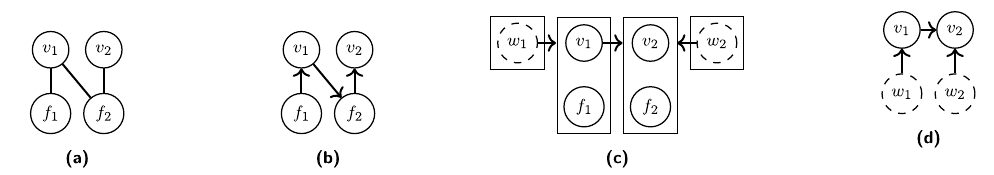
causal ordering graph that is obtained after applying steps 3 and 4 of the causal ordering algorithm is given in Figure 2 ( c ) .